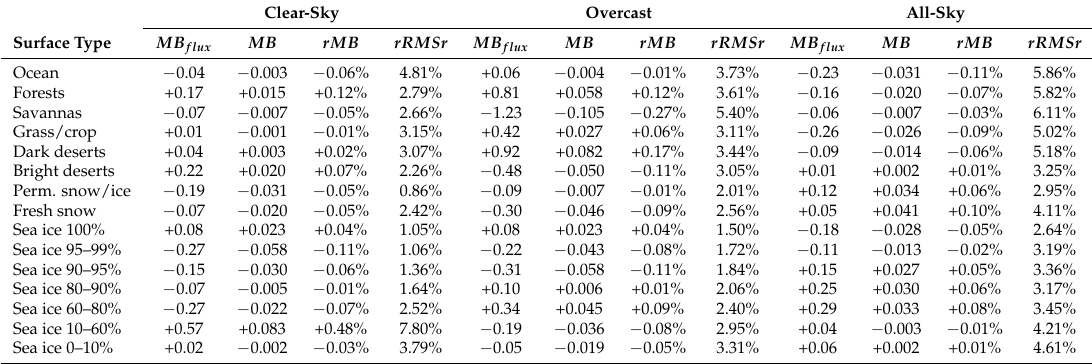
Table 5. Surface-type-dependent regression performance based on smaller validation subset (20% of the NTB pairs with strict matching criteria), stratified per surface type, for clear, overcast, and allsky conditions; Data: 2004–2005 (NOAA17+Terra), 2007–2008 (NOAA18+Aqua) and 2011–2012